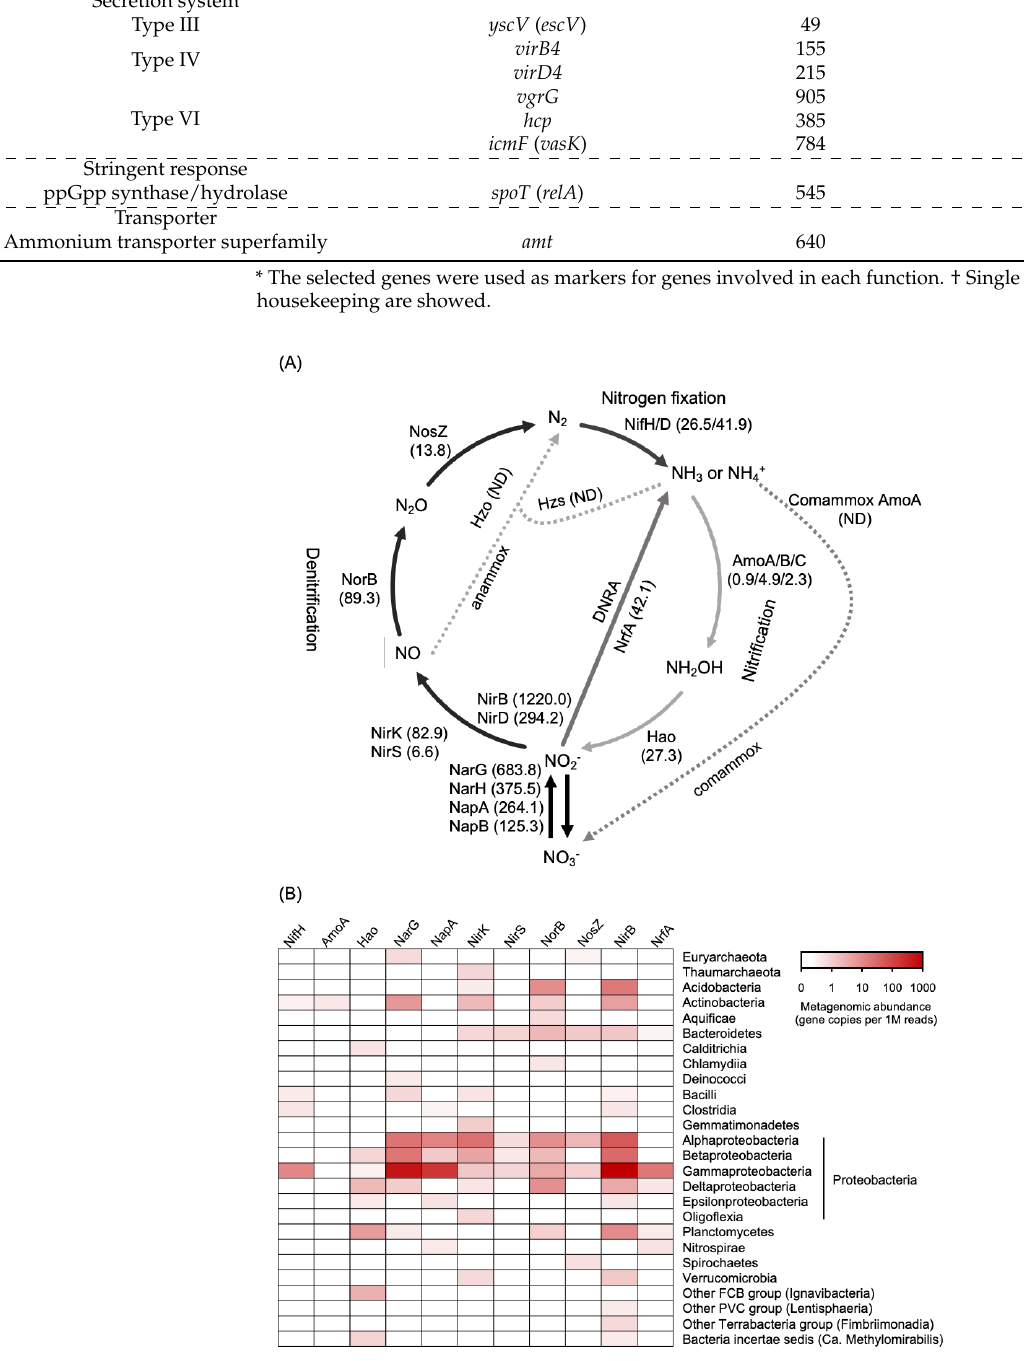
Figure 2. Nitrogen cycle-related genes based on identification with the KEGG database. ( A ), schematic of nitrogen-cycling processes. Arrows indicate direction of reaction. The numbers in parentheses represent the relative abundance of the genes described as gene copies per 1 million mapped